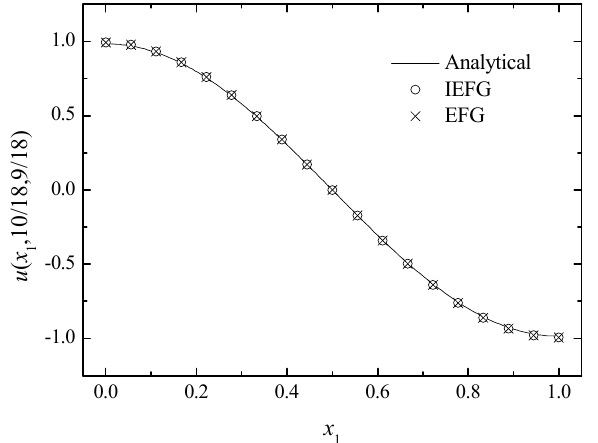
Figure 17. The comparison of the numerical and analytical solutions of the two methods along the x 1 -axis.